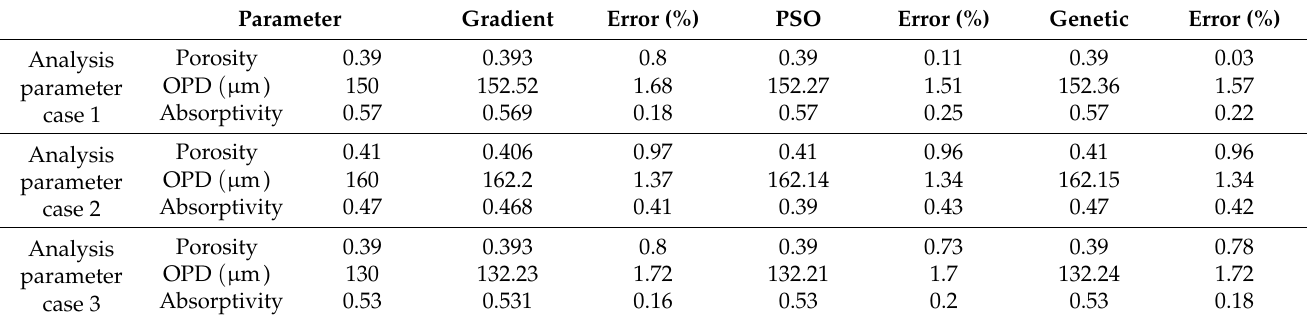
Table 7. Relative error in melt pool size between analysis model and regression model.